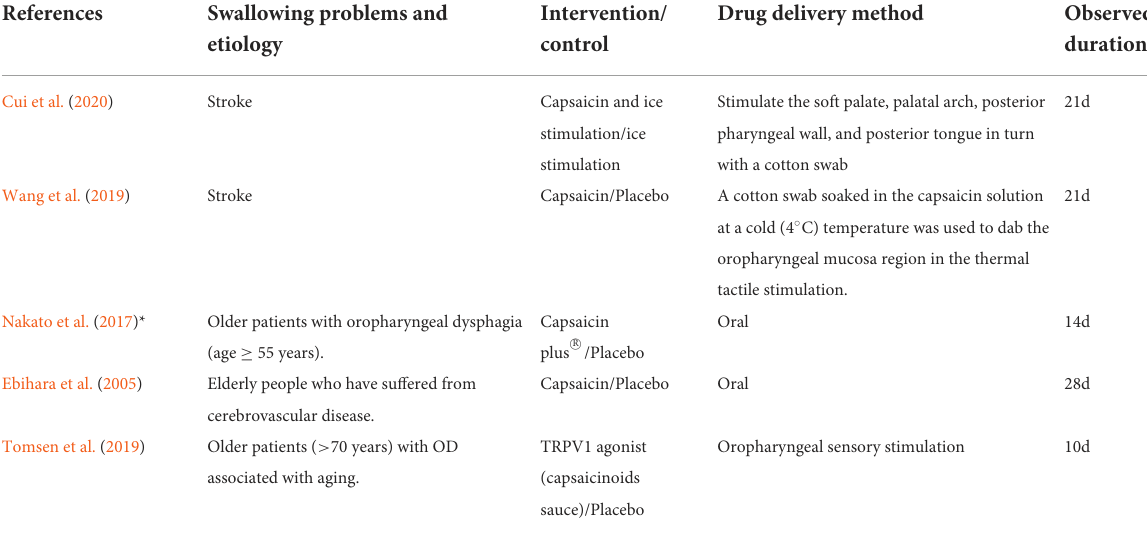
TABLE 1 Study design.